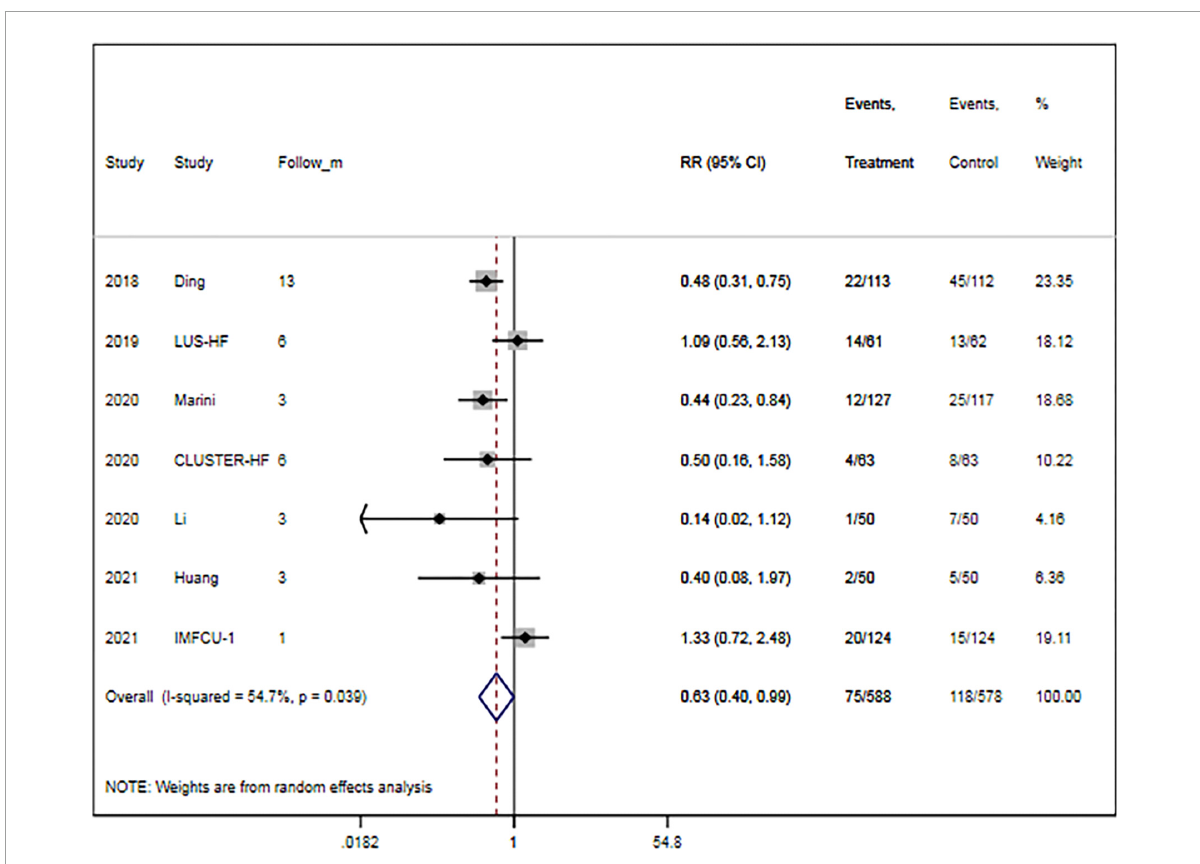
FIGURE4 Lung ultrasound-guided treatment is associated with a decreased risk of heart failure-related rehospitalization. Random-effects model ( I 2 = 54.7%). LUS, lung ultrasound; HF, heart failure; RR, relative risk; CI, confidence interval.